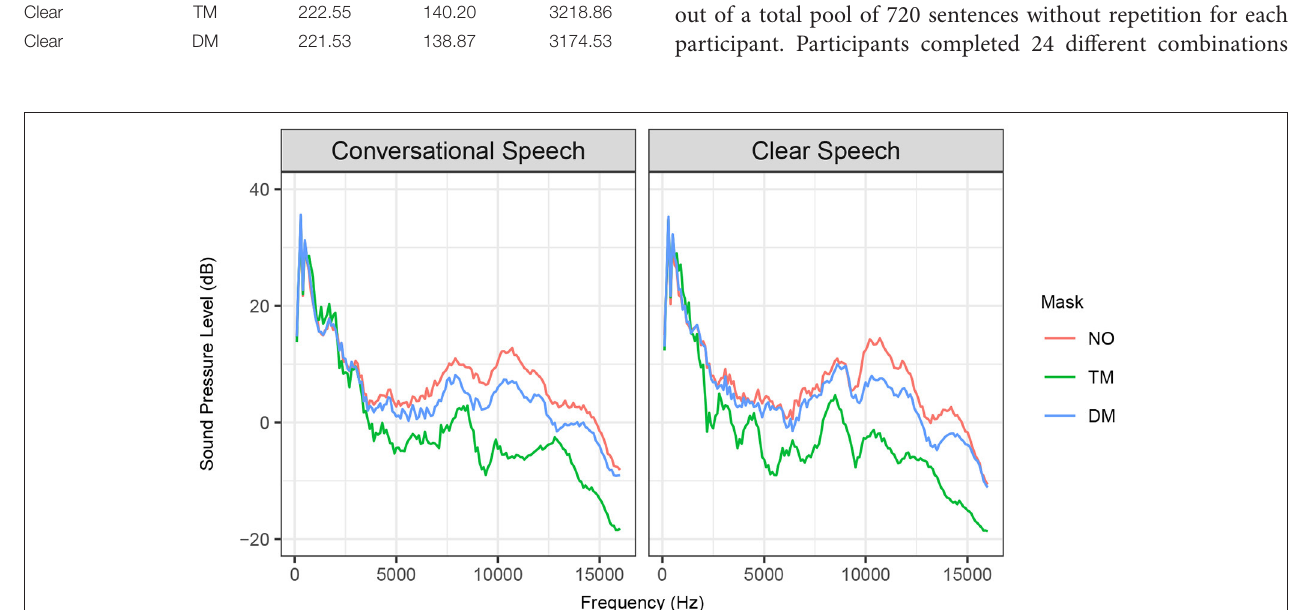
FIGURE 2 | Long-term-average spectrum (LTAS) for conversational speech (left) and clear speech (right) produced with no mask (NO, red line), transparent mask (TM, green line), and disposable face mask (DM, blue line).